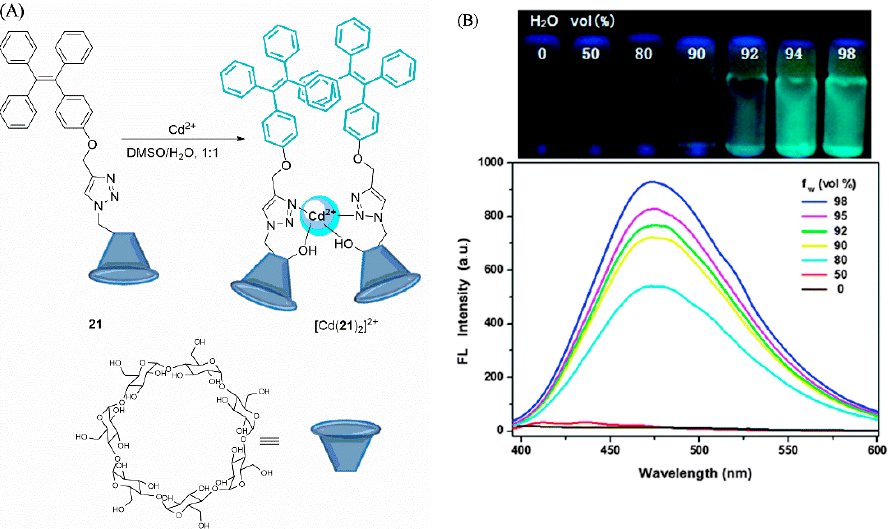
Figure 8. ( A ) The proposed binding mode of chemosensor 21 and Cd 2 + ions and ( B ) the emission turn-on in 50 µ M solution of 21 with a di ff erent ratio of DMSO-H 2 O ( λ ex = 330 nm). Aggregation could be seen by the naked-eye once the water content was greater than 90%. Adapted from [173] with permission from The Royal Society of Chemistry.